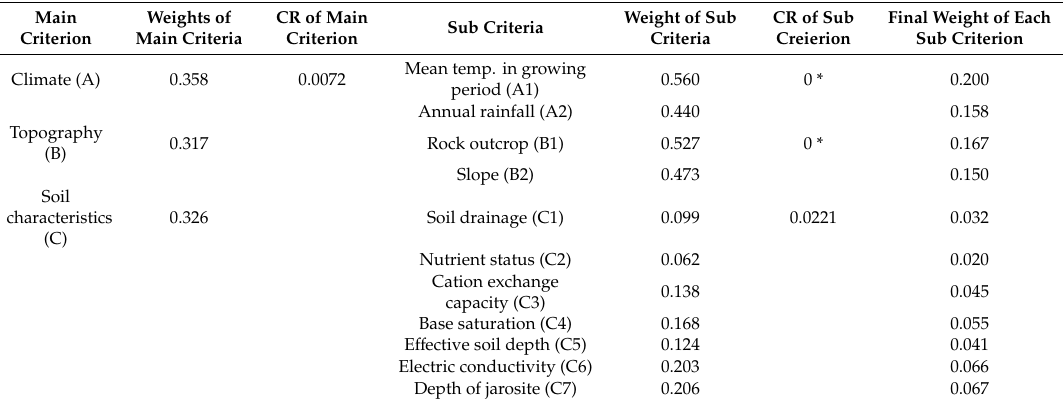
Table 9. Weights of all criteria using trapezoidal fuzzy numbers.